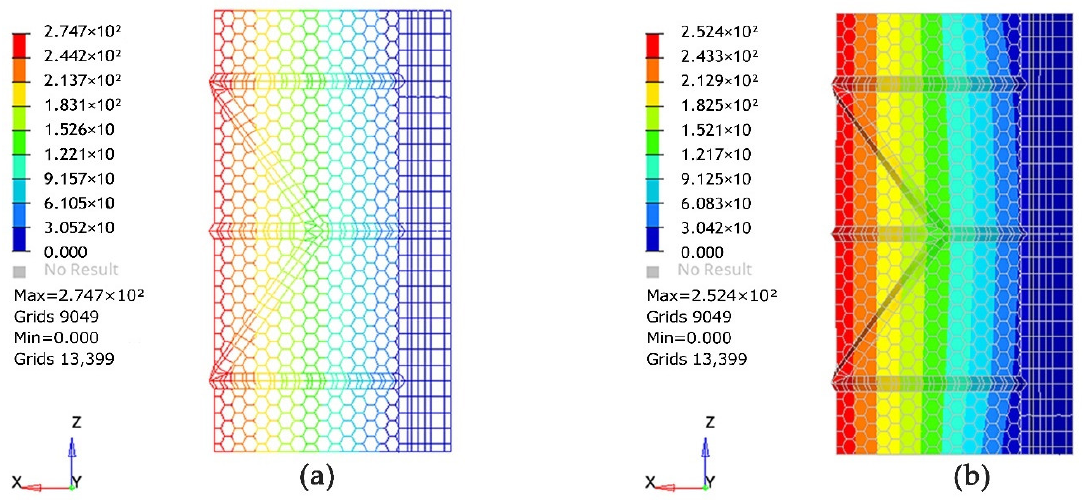
Figure 10. Numerical plots of model I deflection under permanent load plus external load. ( a ) Deflection of model I skeleton under self-weight plus external load. ( b ) The maximum deflection of model I skeleton with membrane cloth under self-weight plus external load.